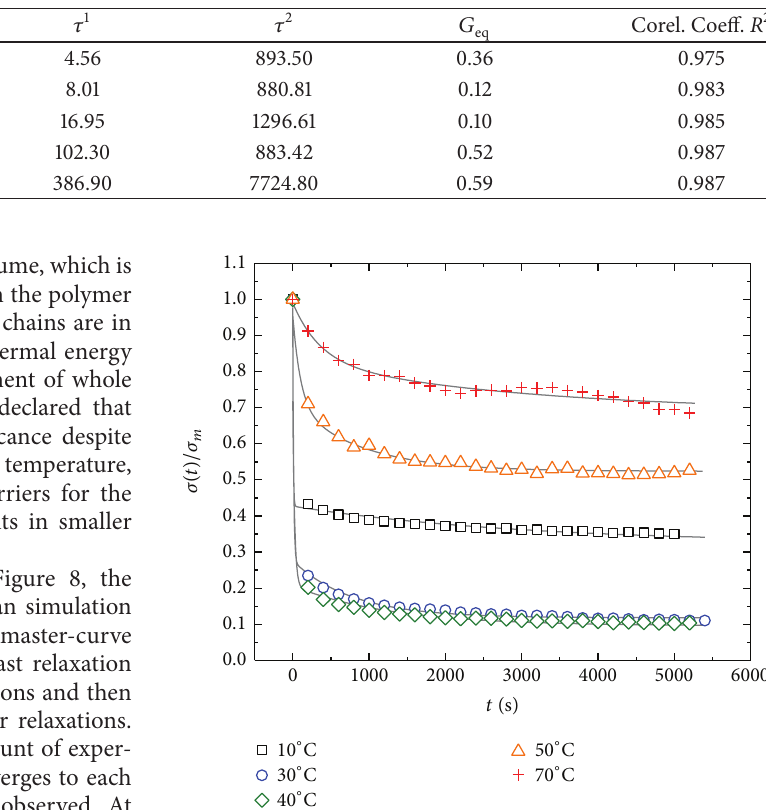
Table 2: Fitting results obtained by the analysis of the relaxation according to the model description of (15) for ESTANE.